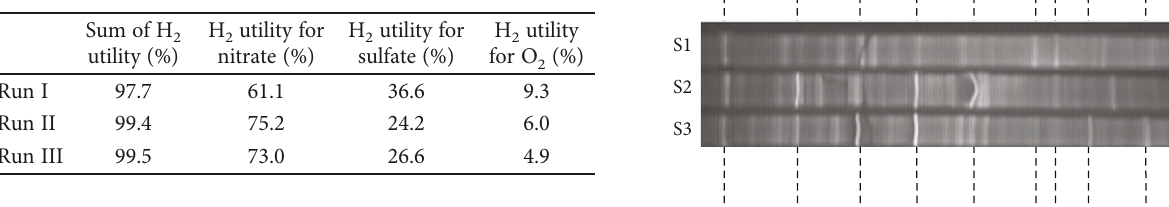
H utility 2 for O 2